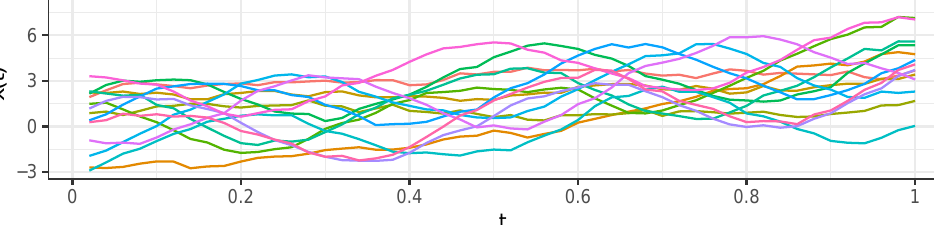
D: The 14 observations labeled as outliers based on MS−Plot